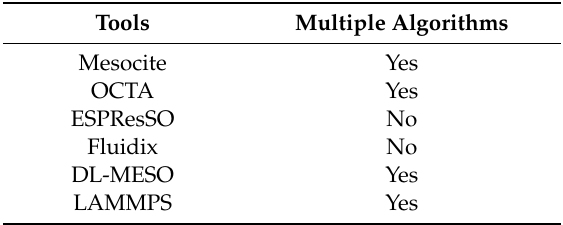
Table 1. Some software packages developed based on the original DPD or the associated improved versions [97].